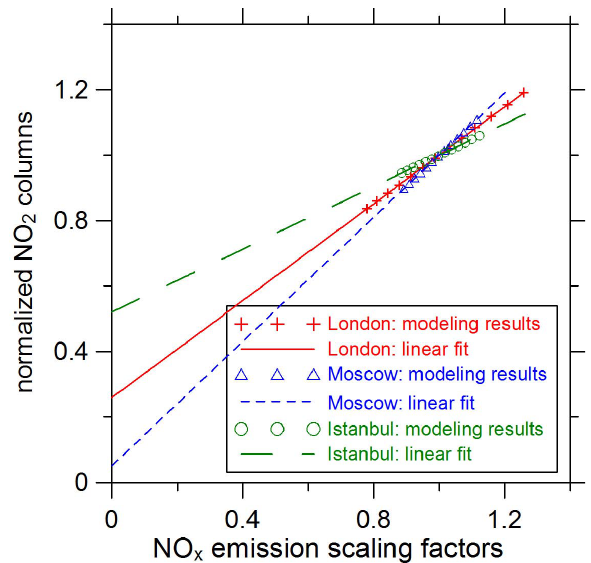
Fig. 3. A model-based test confirming the assumption about a lin- ear dependence of NO 2 columns on NO x emissions in megacity regions: the NO x emission rates for the year 2001 have been scaled within the estimated range of NO x emission changes in correspond- ing megacities from 1996 to 2008. The results are shown for three megacities (London, Moscow and Istanbul) representing different geographical regions. The intercept reflects the “background” NO 2 amounts which are not dependent on anthropogenic NO x emissions in the considered megacities.